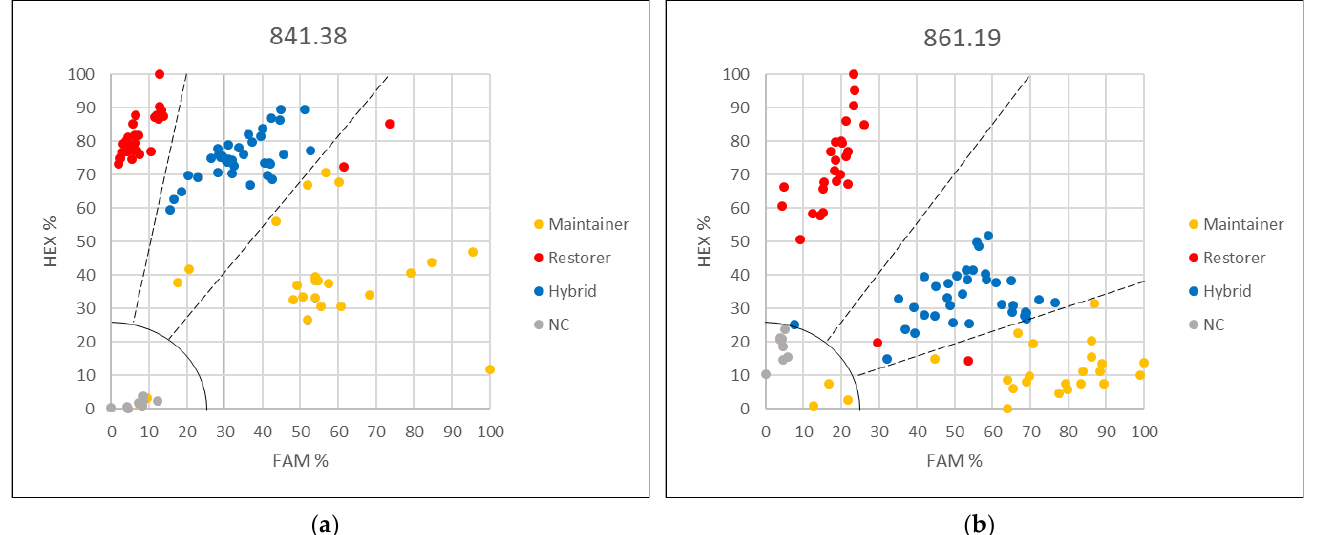
Figure 3. Grouping obtained by KASP markers ( a ) 841.38 and ( b ) 861.19. NC negative control.